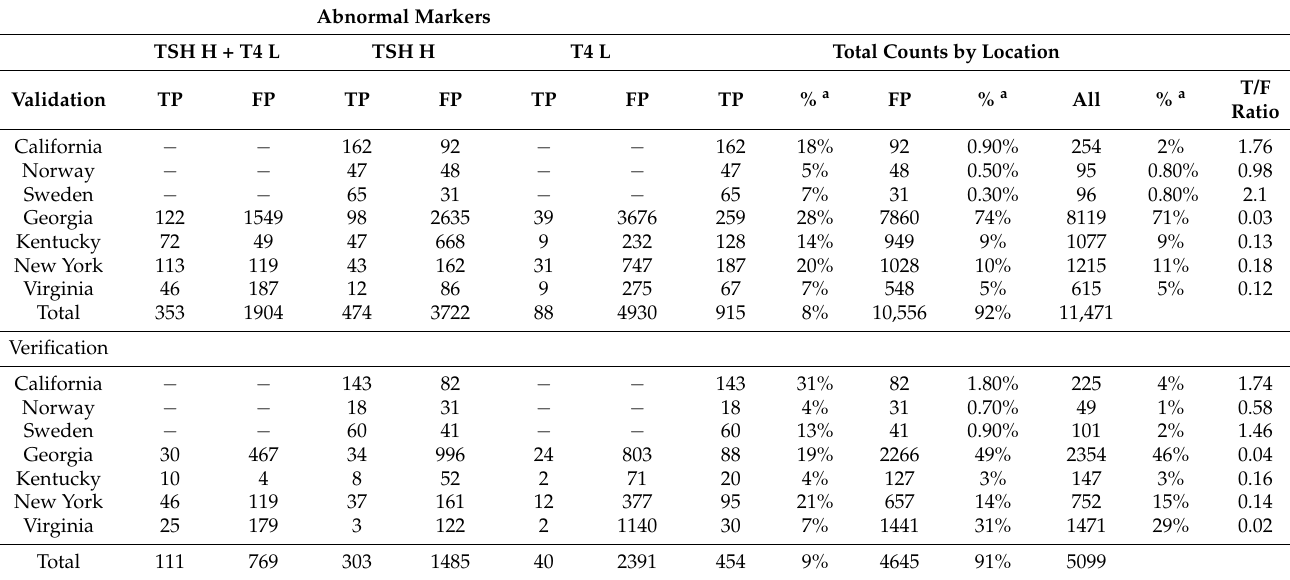
Table 4. Classification and distribution of true and false positive cases in the Validation and Verification datasets after application of the same exclusion criteria applied to reference